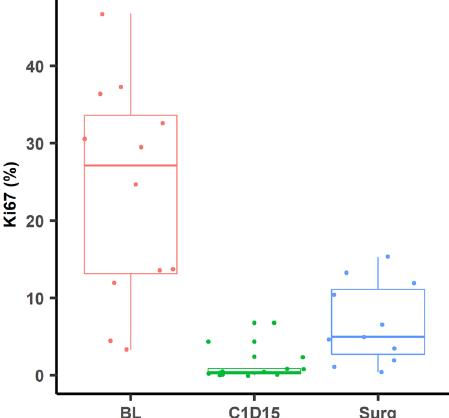
Fig. 2 Boxplots comparing Ki67 scores in samples at baseline, C1D15, and surgery. The center line represents the median (middle quartile), the bounds of the boxes represent the upper and lower quartile, and the whiskers represent the minimum and maximum